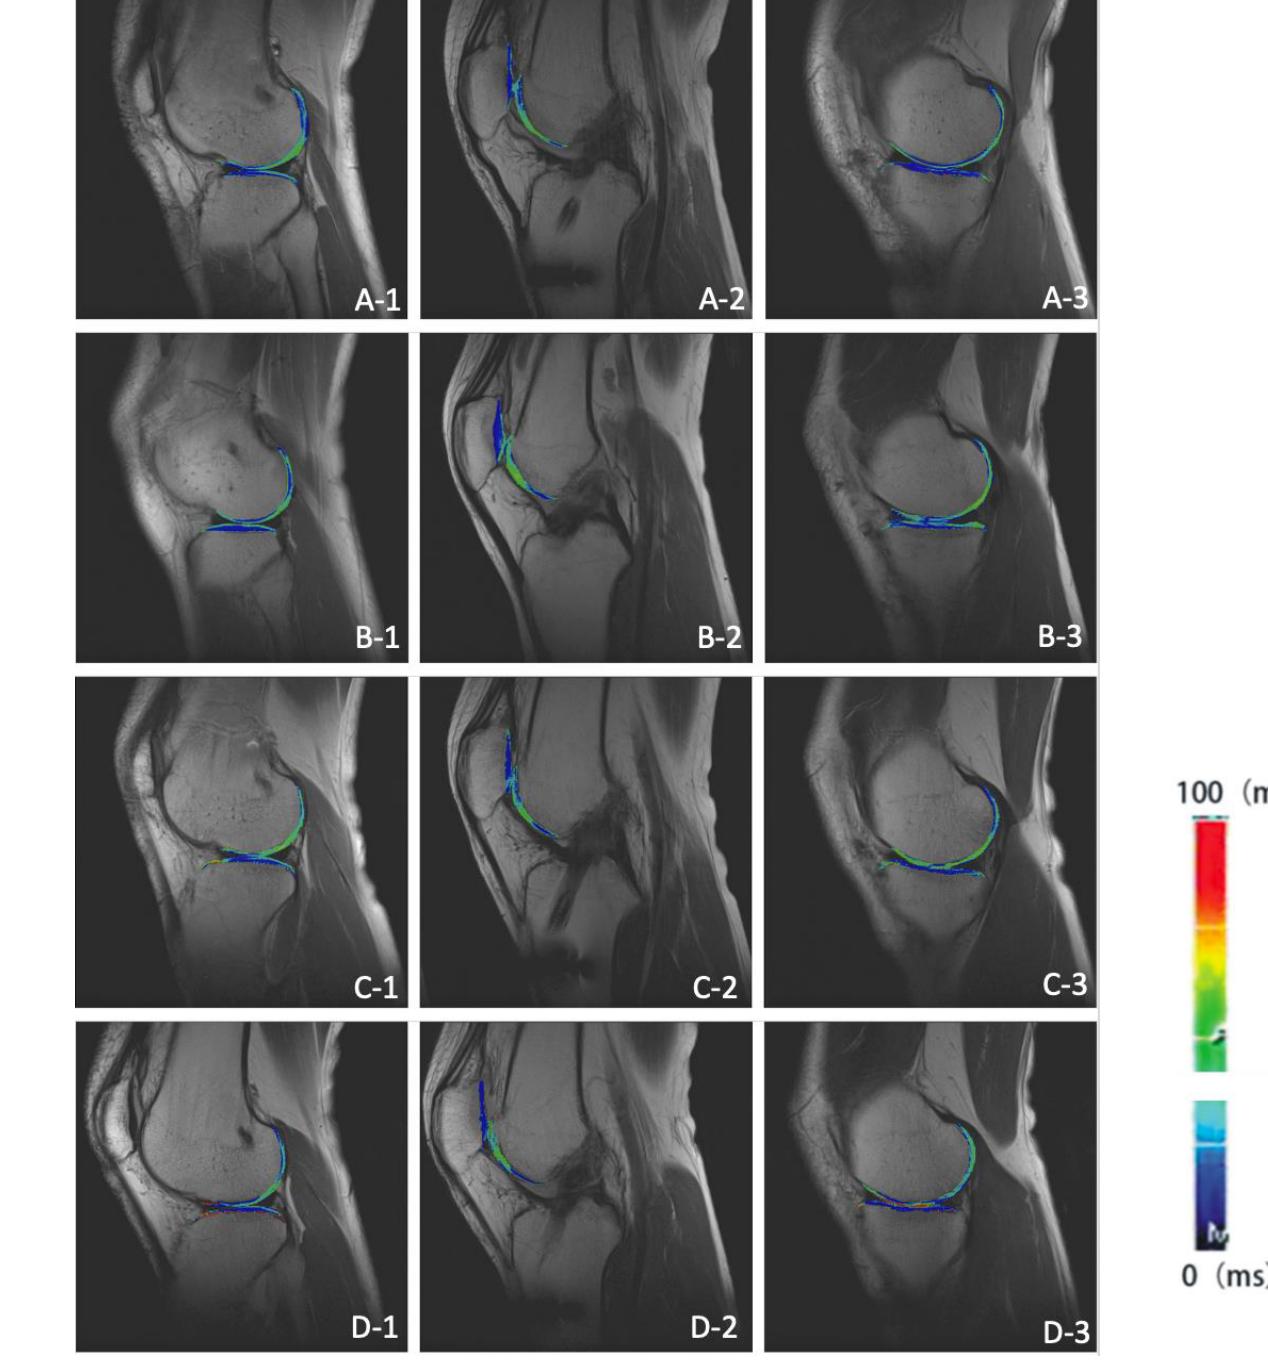
Figure 5. Sagittal T2 mapping of knee joint in HT-PTI group. ( A-1 – A-3 ) show the lateral tibiofemoral joint, patellofemoral joint and medial tibiofemoral joint in HT-PTI group at 6 months after operation; ( B-1 – B-3 ) show the lateral tibiofemoral joint, patellofemoral joint and medial tibiofemoral joint in HT-PTI group 12 months after operation; ( C-1 – C-3 ) show the lateral tibiofemoral joint, patellofemoral joint and medial tibiofemoral joint in HT-PTI group 24 months after operation; ( D-1 – D-3 ) show the lateral tibiofemoral joint, patellofemoral joint and medial tibiofemoral joint in HT-PTI group 60 months after operation.